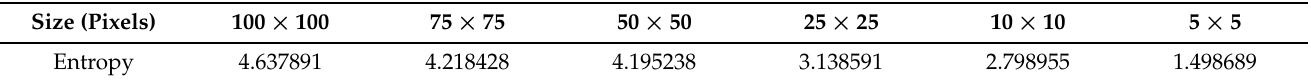
Table 1. The DEMs’ entropy at six distinct scales.